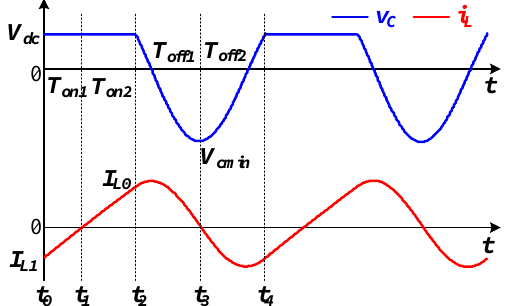
Figure 4. Voltage and current waveforms at maximum input power. When the inductor current i L is zero, the capacitor voltage v C is minimized, and the initial values of the state equations are given as Equation (29).